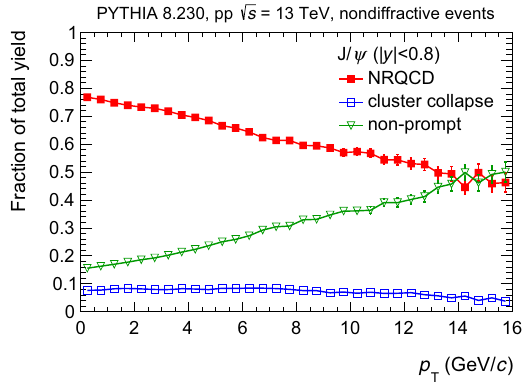
Fig. 4 Left: Relative contributions of different production processes to mid-rapidity J /ψ production as a function of transverse momentum in PYTHIA8. Right: Relative contributions of the different heavy quark